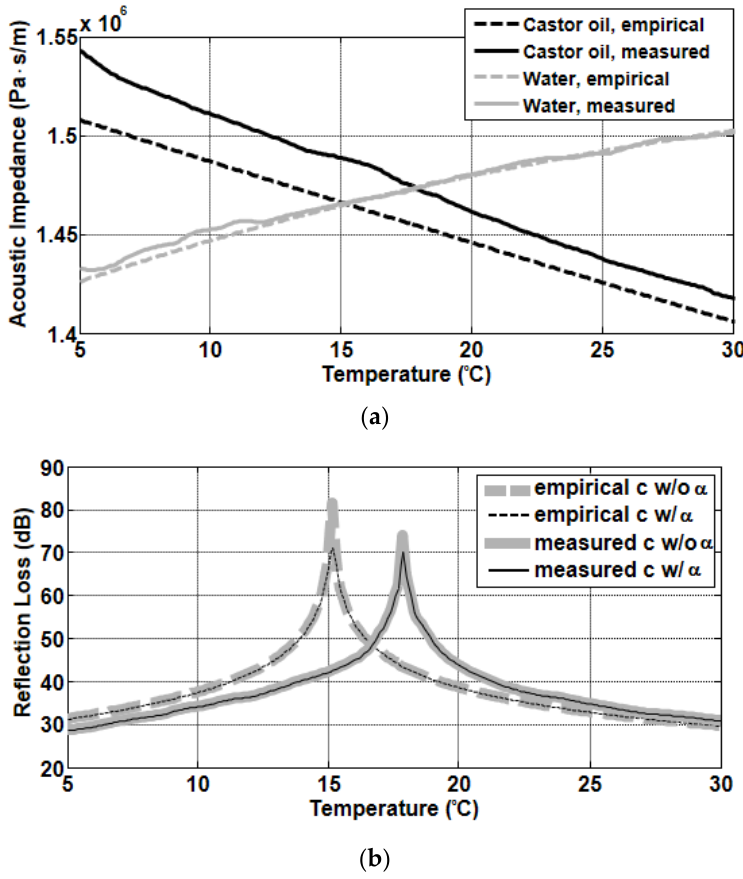
Figure 4. ( a ) Acoustic impedances for normal incidence of castor oil (black lines) and water (gray lines). ( b ) Reflection-loss predictions for water-castor oil interface obtained using −20log 10 |𝑅| based on the Rayleigh reflection coefficients using acoustic impedances in ( a ). Thin and thick lines in ( b ) represent the reflection-loss predictions with and without the castor oil’s attenuation, respectively. In ( b ), solid and dashed lines indicate the predictions estimated using the sound speeds measured and predicted by the empirical formula,